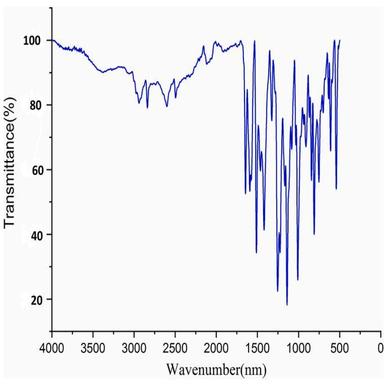
FT-IR SPECTRUM OF CDMBP